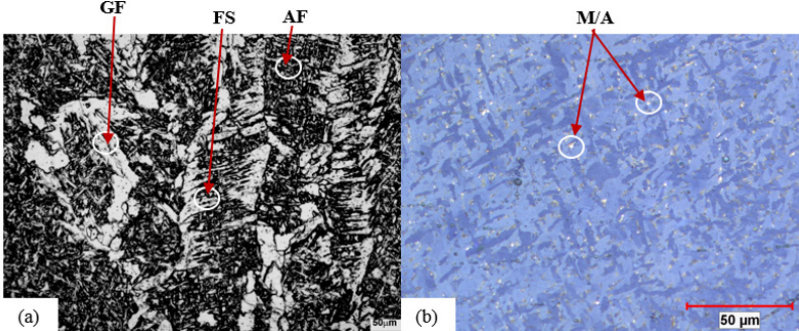
Figure 8: Optical microstructure characterization of weld metal (WM) for T-SAW. (a) 2% Nital etching and (b) Klemm I etching. Table 6: Volume fractions of the HAZ regions compared with the volumetric fraction of the base metal (BM). Experiment HAZ region Volume Fraction of Change of the volumetric ferrite (%) fraction related to BM (%) S-SAW (one wire) FG 62.2 15.9 (Fine grain)